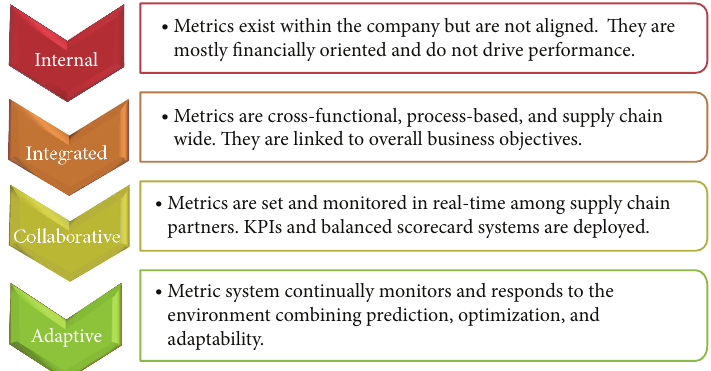
Figure 1: Supply chain performance measurement maturity